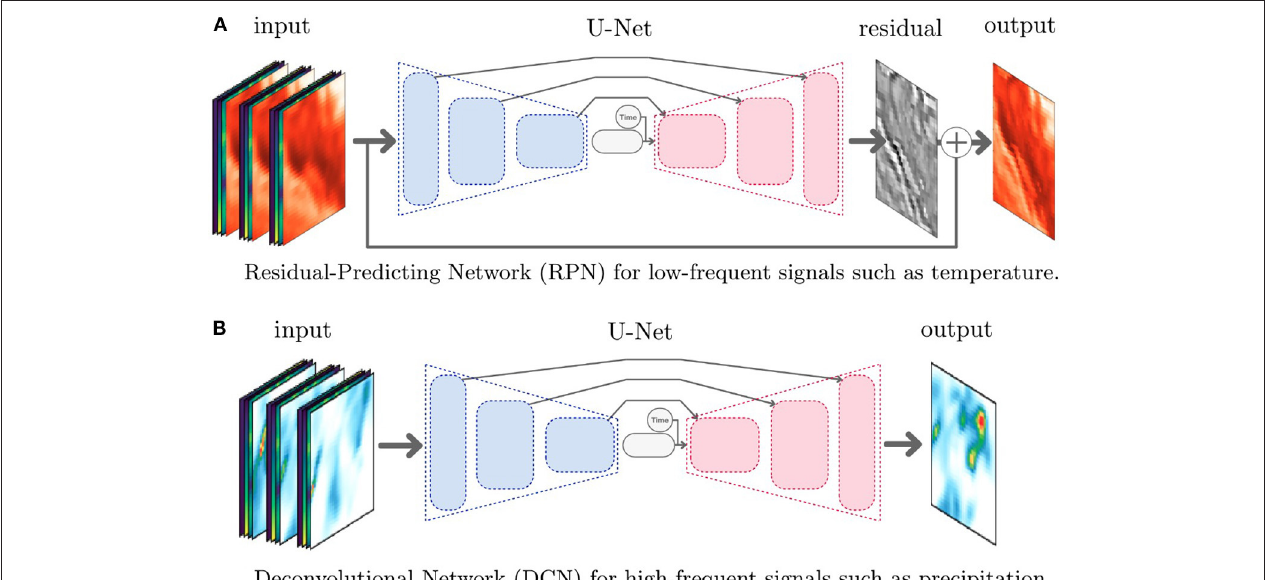
FIGURE 2 | Illustrations of the convolutional neural network architectures for downscaling of low-frequent and high-frequent meteorological variables. Both architectures receive three time steps of the scalar field to predict (temperature or precipitation) and additional fields (longitude, latitude, surface height) as input. For RPN, the input data is downscaled conventionally in both space and time. For DCN, the input data is downscaled conventionally only in space. In both networks, the time variable is appended in the latent space and indicates at which relative time between the input frames the output should be downscaled at. (A) Residual-predicting network (RPN) for low-frequent signals, such as temperature. (B) Deconvolutional network (DCN) for high-frequent signals, such as